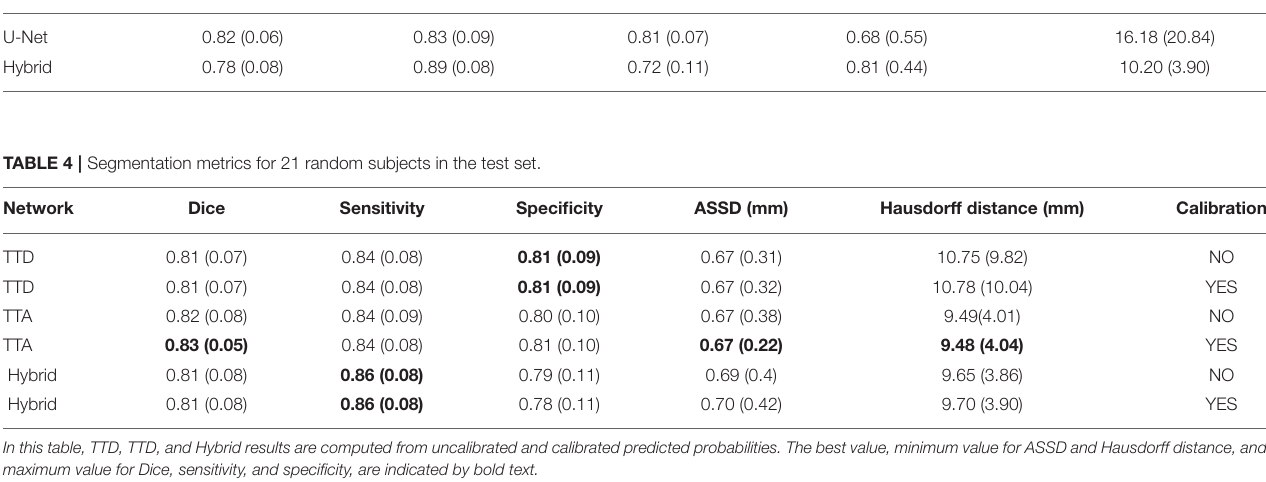
TABLE 3 | Dice, sensitivity, specificity, ASSD, and Hausdorff distance evaluation for deterministic (U-Net) and stochastic Hybrid approaches for clinical quality data. Network